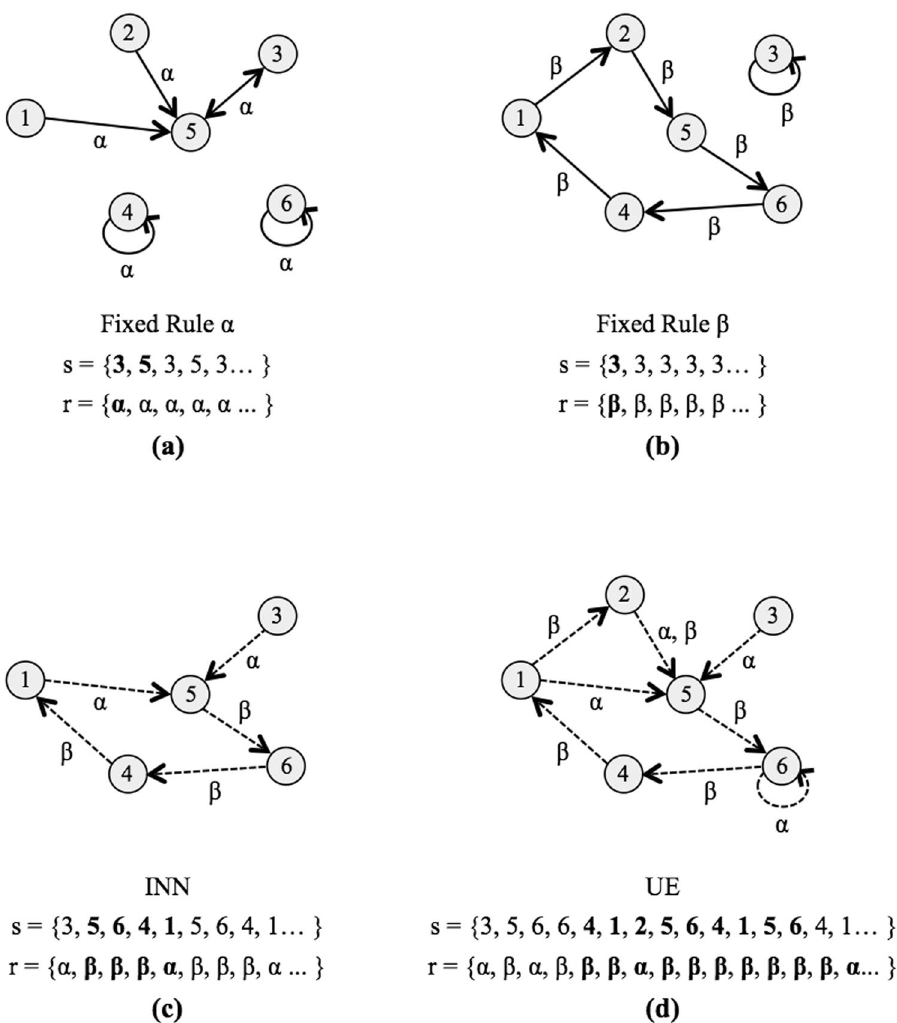
Figure 1. State diagrams: A hypothetical example demonstrating the concepts of INN and UE. The possible set of states are S = {1, 2, 3, 4, 5, 6} and rules R = { α , β }. For each panel, the example state trajectory s is initialized with starting state s o = 3. For panels c and d the rule trajectory r is also shown. Highlighted in bold is the first iteration of the attractor for states (all panels) or rules (panel (c,d) only). For a discrete deterministic system of six states, the Poincaré recurrence time is t P = 6. Panel (a) shows the state transition diagram for hypothetical rule α where a trajectory initialized at s ( t 0 ) = 3 visits two states. Panel (b) shows the state transition diagram for hypothetical rule β where a trajectory initialized at s ( t 0 ) = 3 visits only one state. Since the trajectories in ( a , b ) evolve according to a fixed rule (are isolated) they do not display INN or UE and in general the recurrence time  t t . Panel (c) demonstrates INN , where the trajectory shown cannot be fully described by rule α or rule β r P alone. The state trajectory s and rule trajectory r both have a recurrence time of t r = 5, which is less than t P so this example does not exhibit UE. Panel (d) exhibits UE (and is also an example of INN). The trajectory shown cannot be described by rule α or rule β alone. The recurrence time for the state trajectory is t r = 13, which is greater than t P . The rule trajectory also satisfies the conditions for UE, with a recurrence time in this example that is longer than that of the state trajectory due to the fact that the state transition 2 → 5 could be driven by rule α or β depending on the coupling to an external